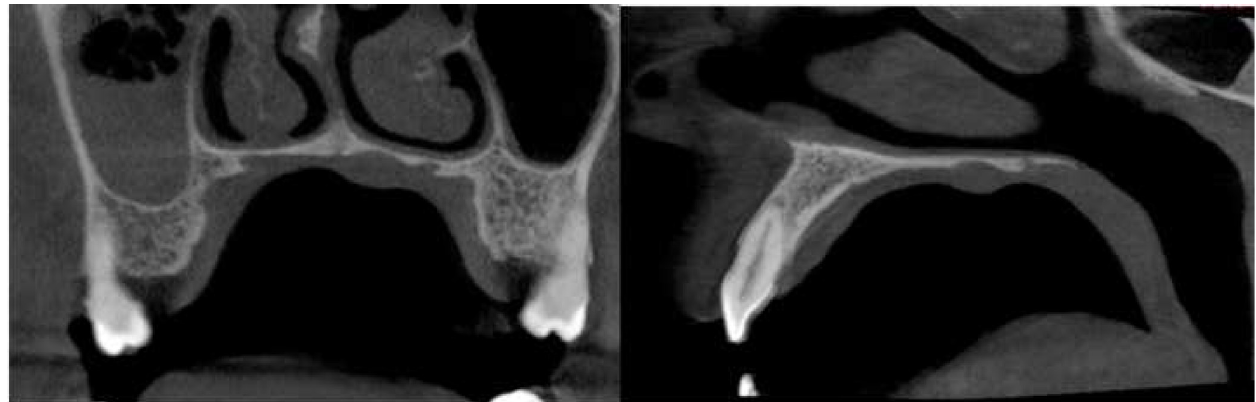
Fig. 2. CBCT views showing local cup-shaped bone involvement on coronal and parasagittal views. The tumor is well-delimited within the soft tissues. Of notice: the hyperplastic mucosa of the right sinus with local “ air- fl uid ” levels.